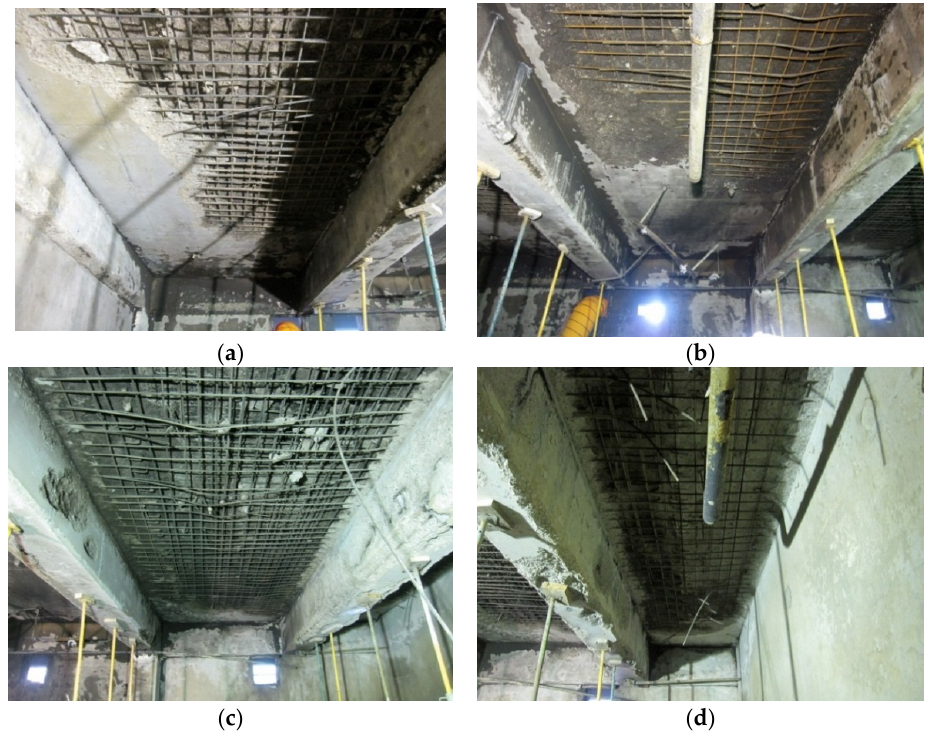
Figure 3. Damage in each span of slab on its soffit, observed from the north. ( a ) Slab #1, ( b ) Slab #2, ( c ) Slab #3 and ( d ) Slab #4.